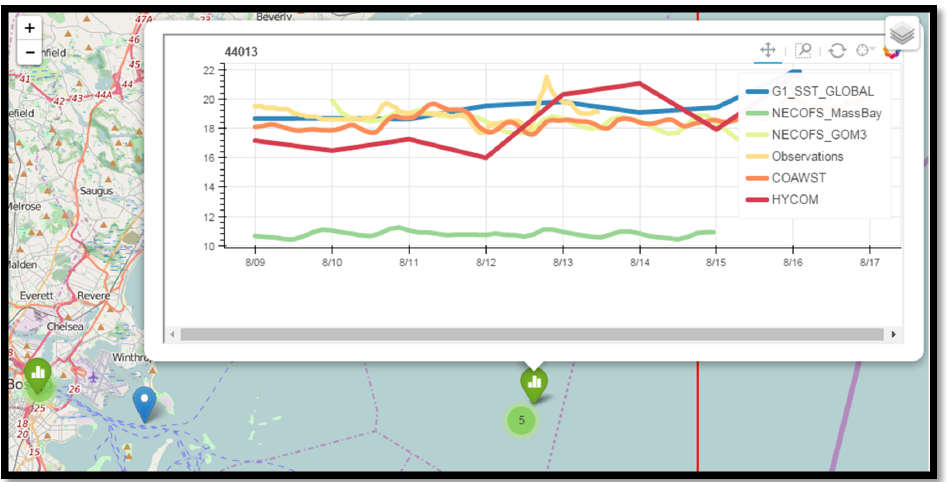
Figure 9. Screenshot from the Map Display notebook, showing the NECOFS_MassBay model about 8 °C colder than observations, and the COAWST model is now within a degree of observations. The global HYCOM model appears here also, and is within a few degrees of the observations.